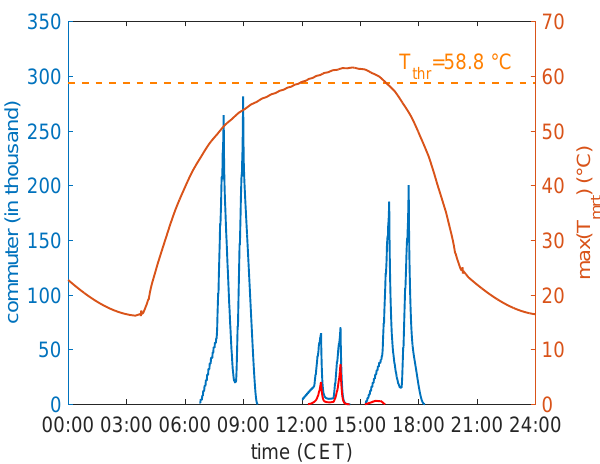
Figure 8. Time series of simulated total commuters (blue), exposed commuters (red) and the maximum T mrt (orange) in the city for 4 July 2015. As a threshold for heat stress 58.8 ◦ C is used (dashed orange